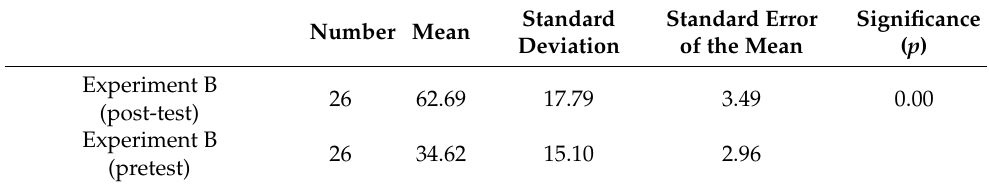
Table 4. Pretest and post-test t -test analyses of Experimental group B.